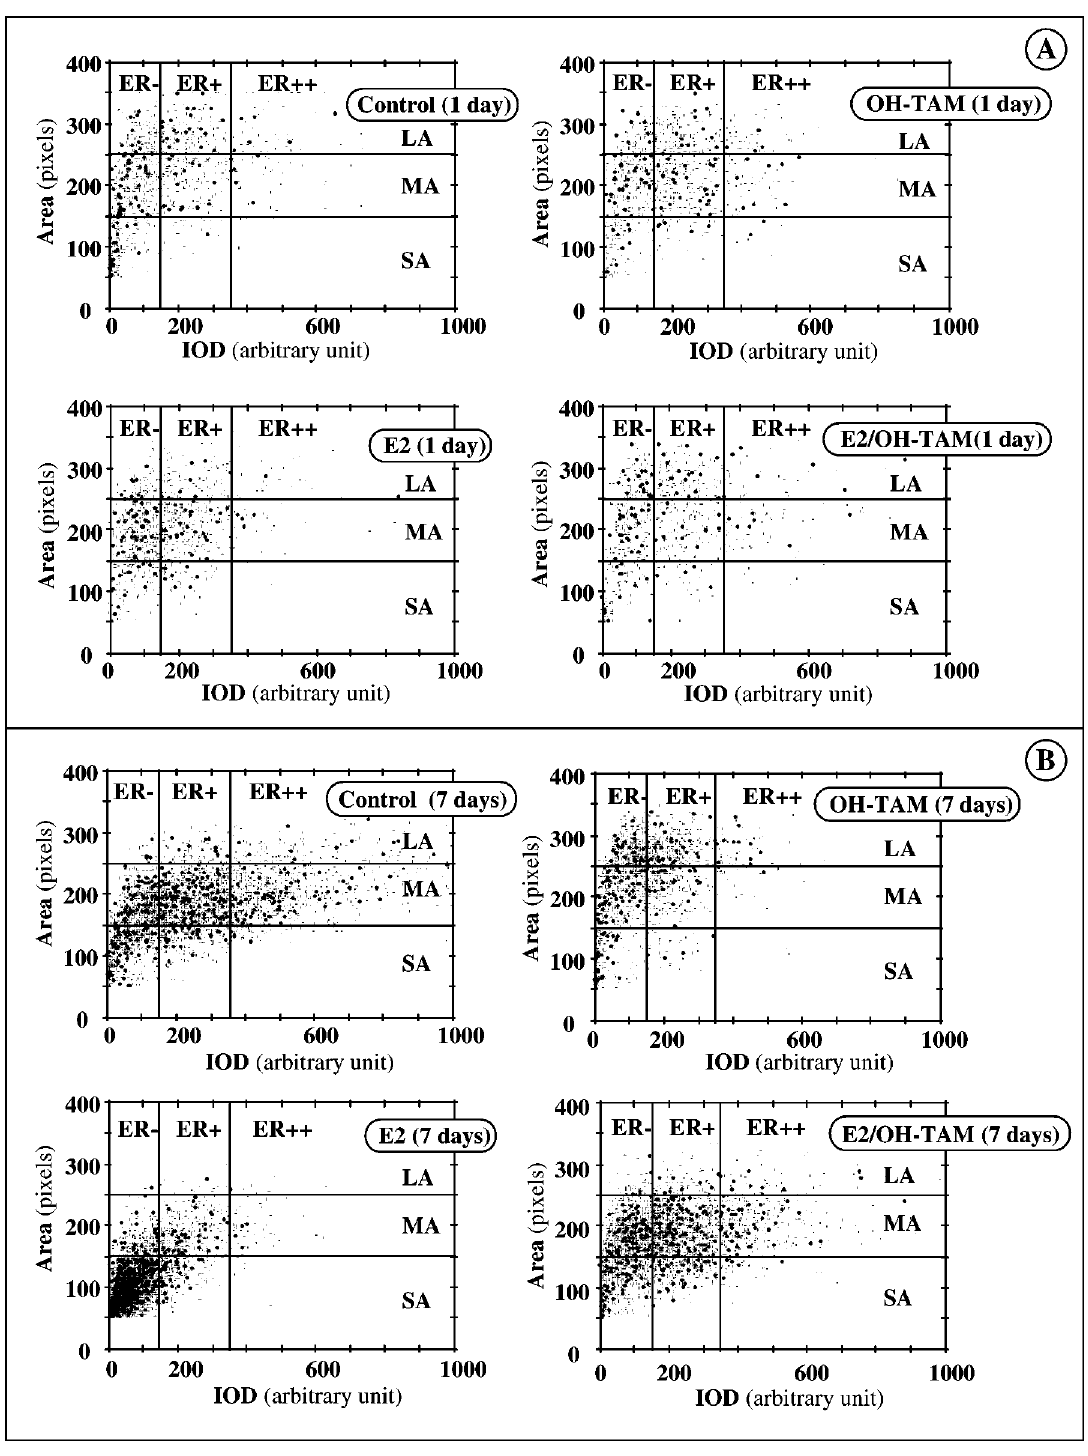
Fig. 4. Bidimensional relative plot of integrated optical density (IOD) and nuclear area (A) of MCF-7 cells. A: 1 day of treatment (3 days of culture). B: 7 days of treatment (9 days of culture). The thresholds between the different populations of nuclear size and nuclear estrogen receptor content are